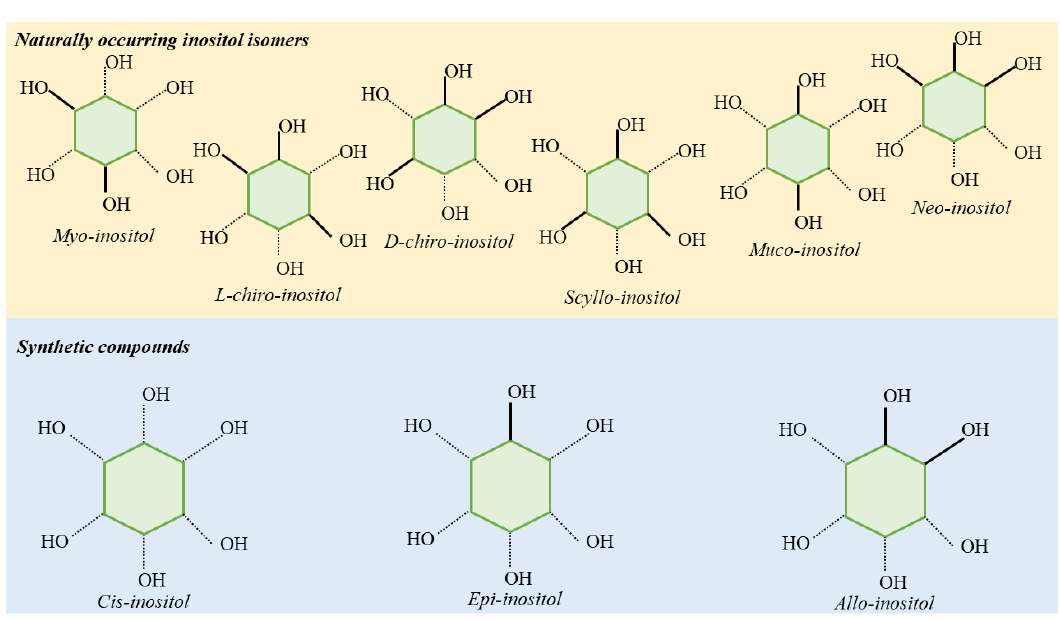
Figure 1. Inositol stereoisomers. Myo-, D-chiro-, L-chiro, Muco-, Scyllo-, and Neo- are the isomers naturally found in plants and animals. Allo-, cis-, and epi- stereoisomers are the synthetically obtained compounds.